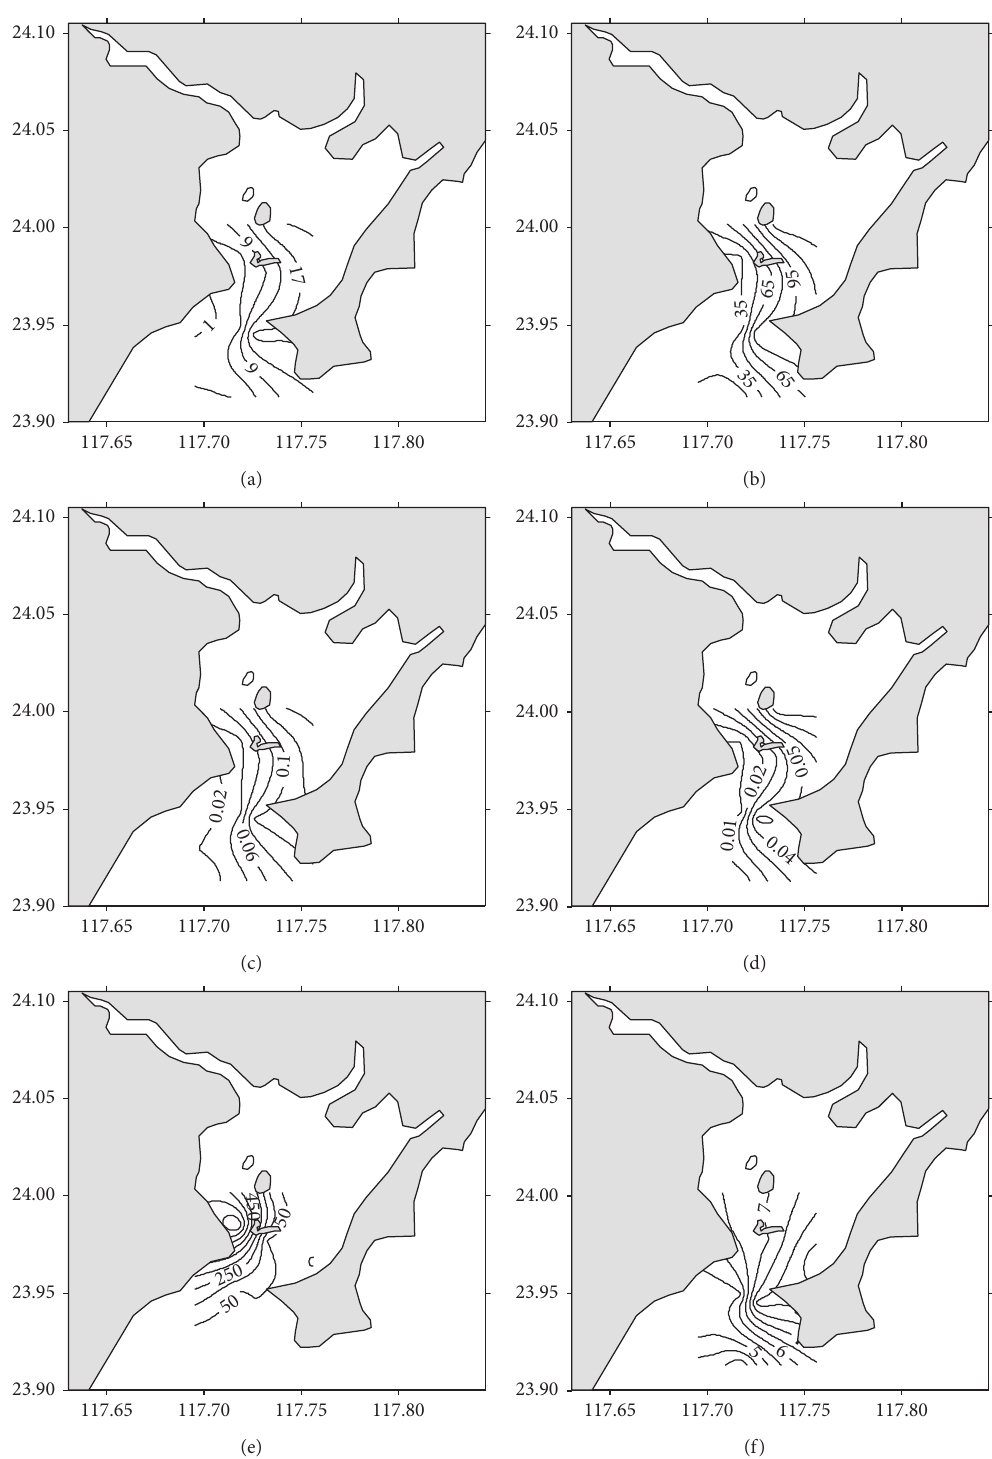
Figure 3: Distributions of various heavy metals in sediments of Jiuzhen Bay ( µ g/g dw): (a) Cu; (b) Zn; (c) Cd; (d) Hg; (e) Pb; (f)